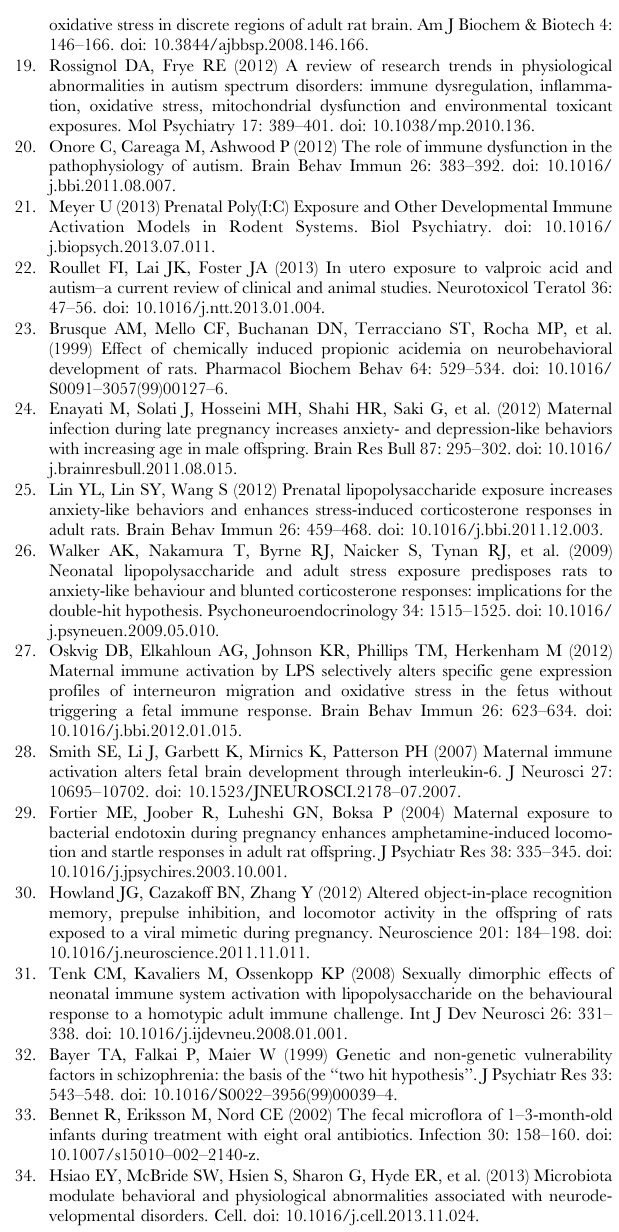
S.E.M. Refer to Table 1 for group designations and sample sizes. Figure S4 Additional thigmotaxis measures (P42) in male and female offspring. Activity measures were time corrected. A: Total distance traveled in the perimeter (cm/s). B: Horizontal movement time in the perimeter (s). Females were significantly greater than males for both total distance and movement time, p s , 0.01. C: Number of vertical movements in the perimeter. D: Vertical time in the perimeter. There were no significant differences in vertical measures. E. Horizontal move- ment time in the centre (s). Prenatal PPA treated females spent significantly more time moving than prenatal 5VEH treated females. F: Vertical time (s) in the centre. Error bars represent